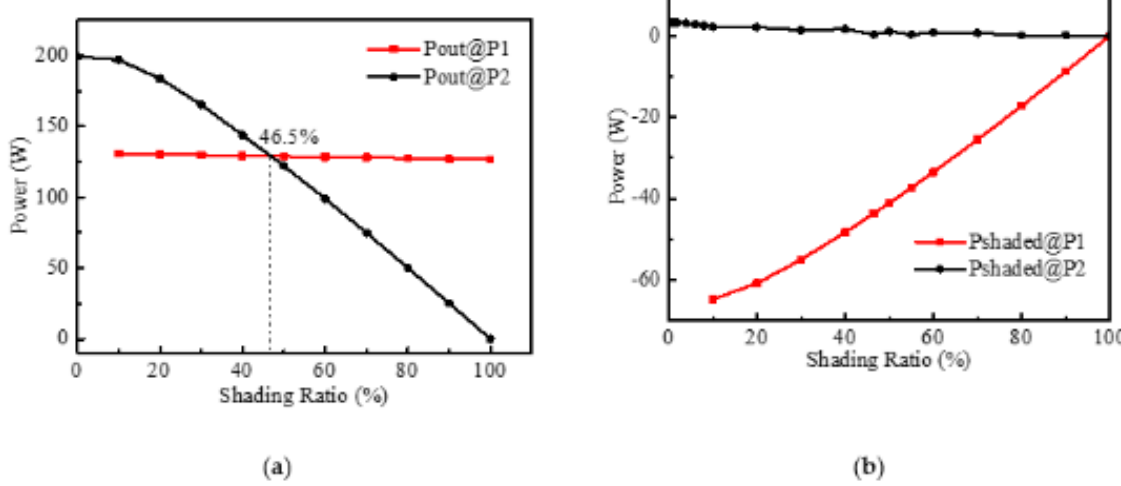
Figure 8. Output power of PV module ( a ) and shadowed solar cell ( b ) when the module is working at Peak 1 and Peak 2 separately with different shading ratios.